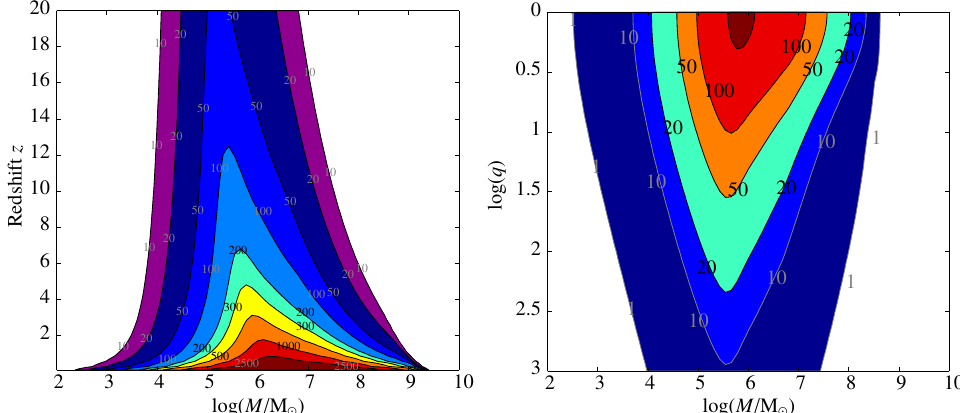
Figure 3: Contours of constant SNR for MBH binaries observed with eLISA. The left-hand panel shows contours in the total-mass–redshift plane for equal-mass binaries, while the right-hand panel shows contours in the total-mass–mass-ratio plane for sources at redshift 𝑧 = 4. Image reproduced by permission from [21]. The practical detection of MBH systems will have to rely on careful data analysis.